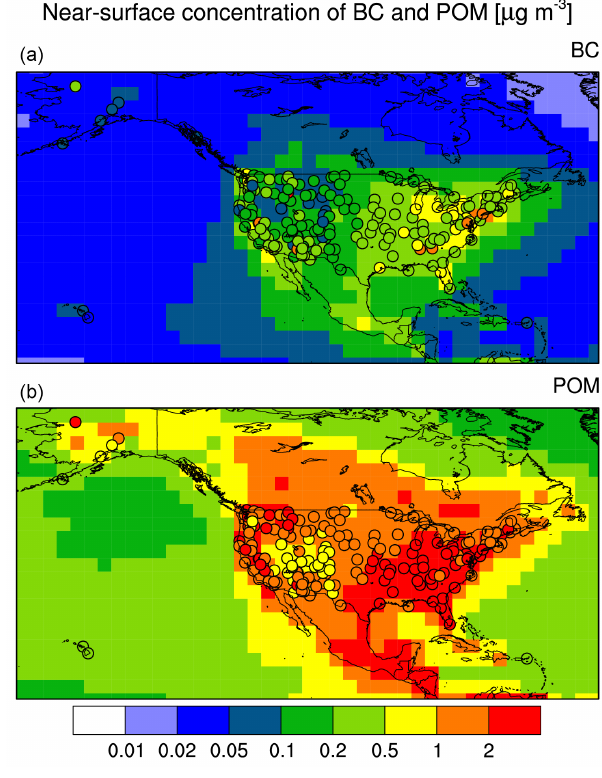
Figure 3. EMAC simulation with MADE3 (background color; “pix- els” correspond to the model grid) vs. observations from the station network IMPROVE (filled circles): near-surface BC (a) and POM (b) mass